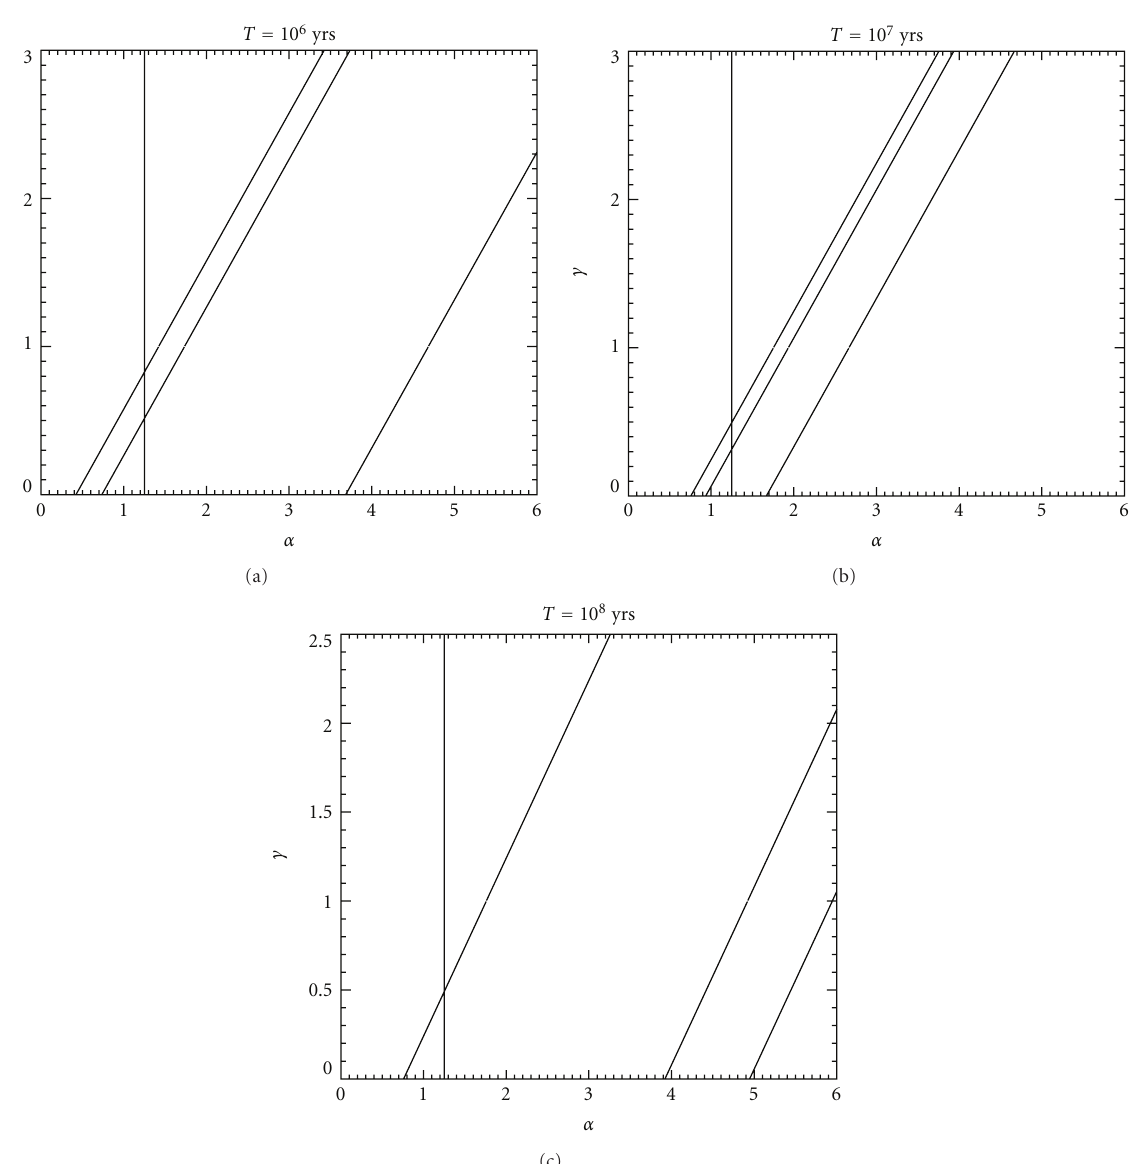
Figure 15: The IMF power-law slope as a function of the PDMF power-law slope for the case of episodic star formation. In each panel the lowest line is Δ t = 10 8 yrs and the highest line is Δ t = 10 6